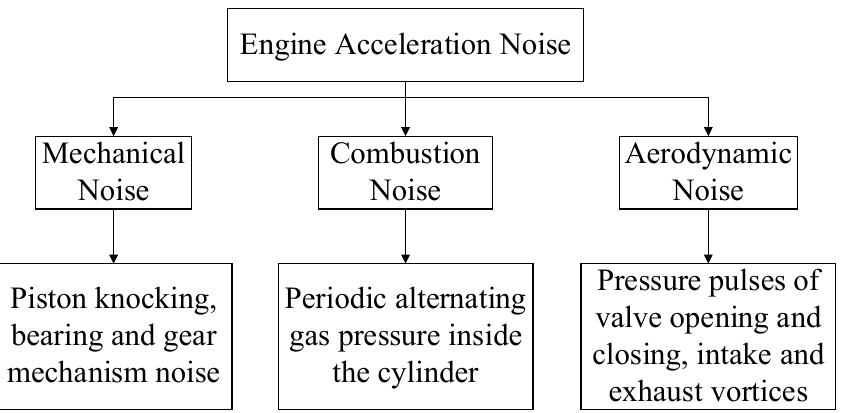
Figure 2. Main engine noise components.